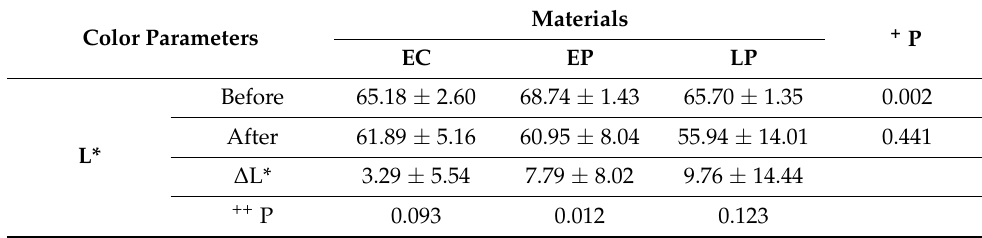
Table 3. The changes in color parameters ( ∆ L*, ∆ a*, ∆ b*) analysis in terms of brushing effect.